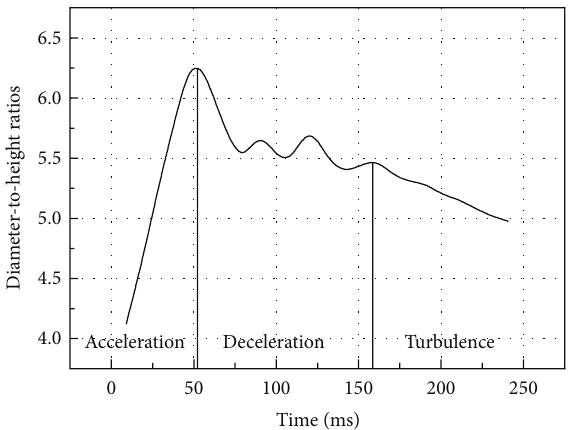
Figure 4: Diameter-to-height ratios 𝜀 of cylinder cloud of fuel-air mixtures versus time. Table 1: Changing rate of various diameters at the fixed distances. Distance/m